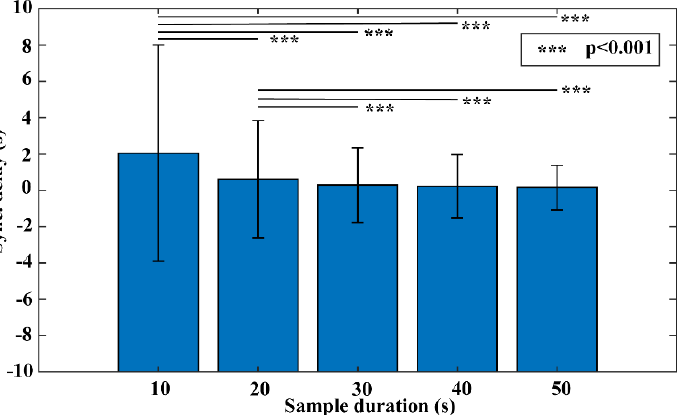
Figure 1. The association between sample durations and time − alignment algorithm performance.